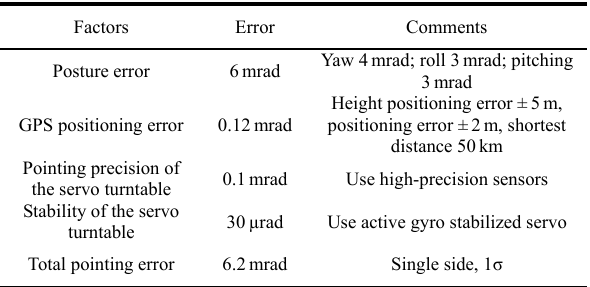
Table 1 FOU analysis.